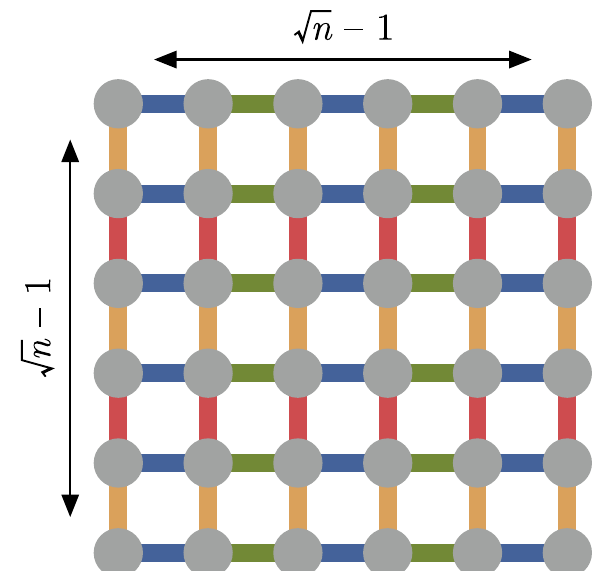
Fig. 4 Cycles of a random circuit sampling experiment on an n - qubit planar architecture. Each cycle consists of single-qubit gates followed by a pattern of two-qubit gates, such as those highlighted by a single color in the diagram.